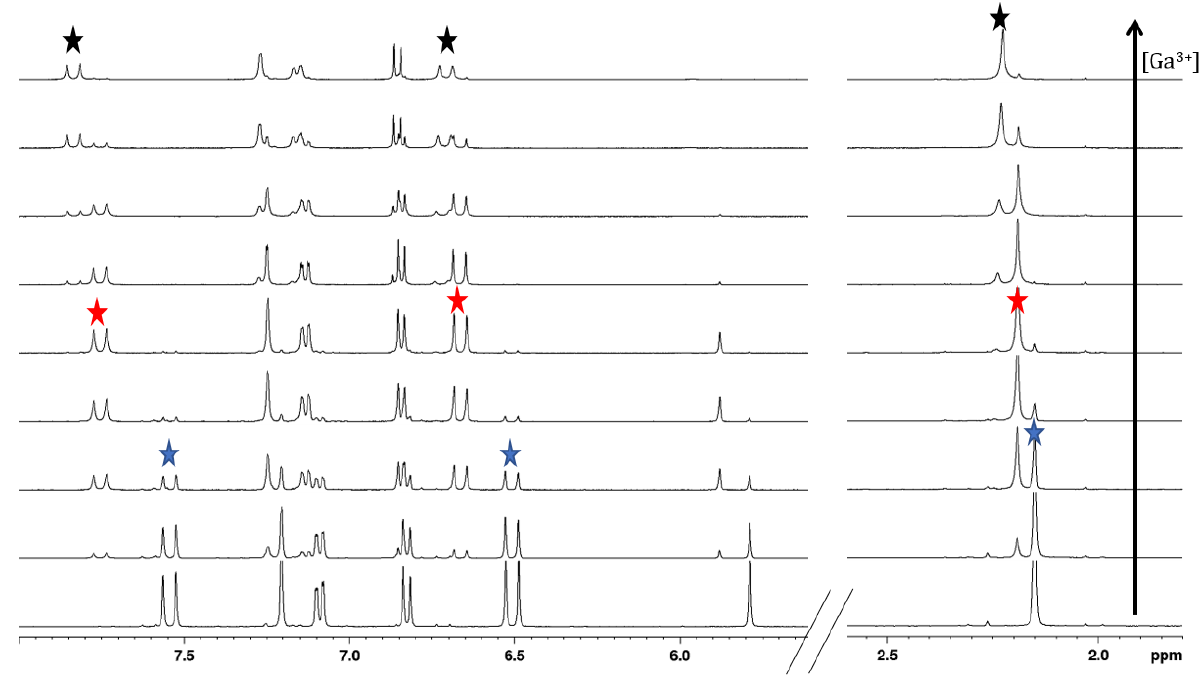
Figure 7. 1 H NMR spectra of compound 1 in MeOD- d 4 at 298 K (at 600 MHz) at increasing addition of a Ga 3+ MeOD- d 4 solution up to the metal-to-ligand 1:1.5 molar ratio. The stars highlight resonances of protons H-1, H-3 and H-4 in the free ligand (blue), M:L 1:2 complex (red) and M:L 1:1 complex (black).